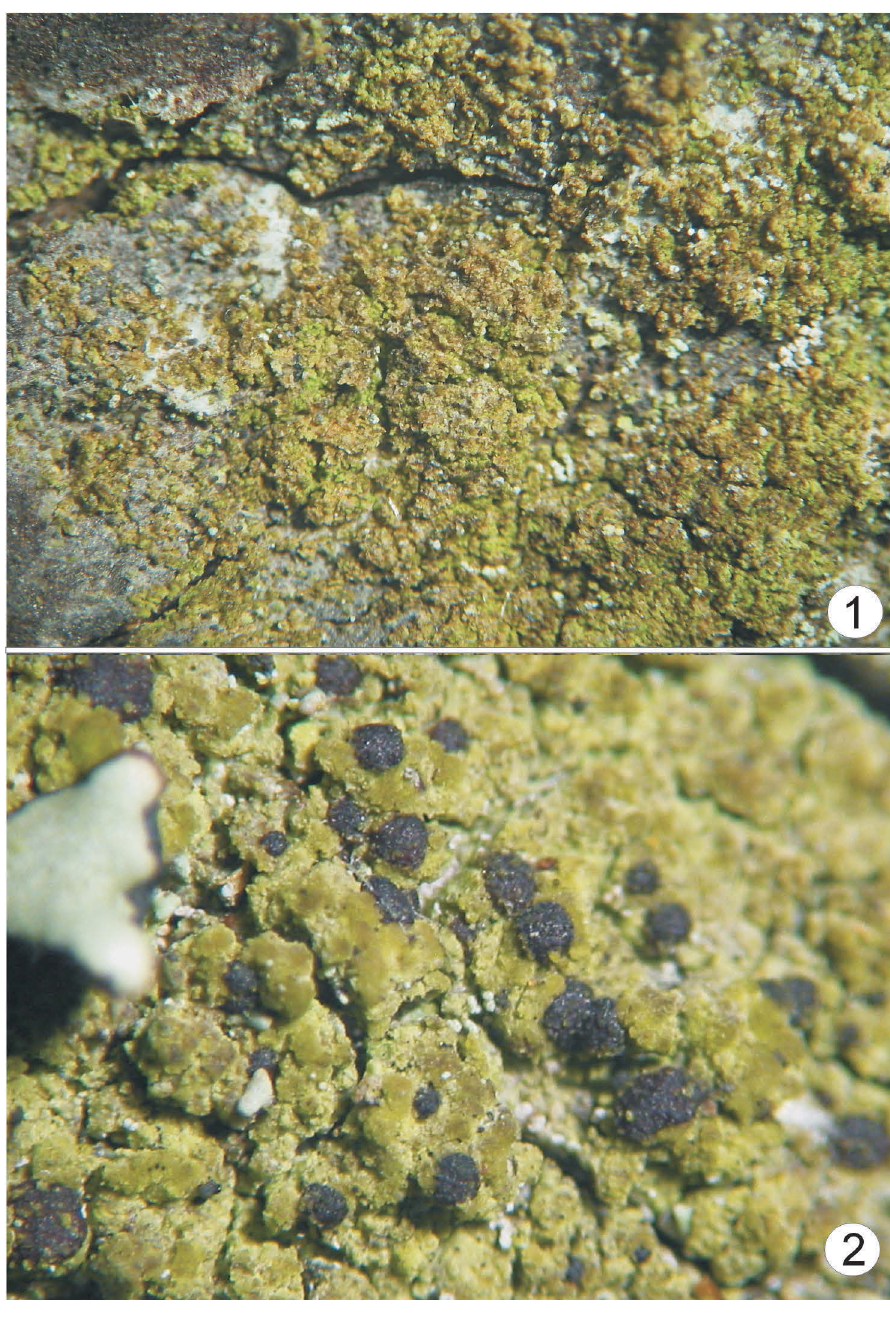
Figs 1-2. Habits of Japewia : 1. J. subaurifera ( Czarnota, GPN 5981), 2. J. tornoensis ( Czarnota , GPN